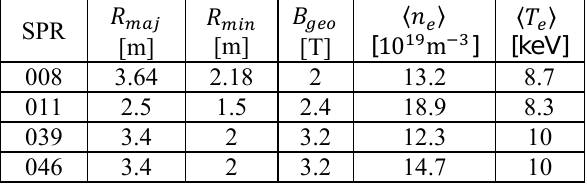
Table 1. Important geometrical and plasma parameters for SPRs considered in the scans.